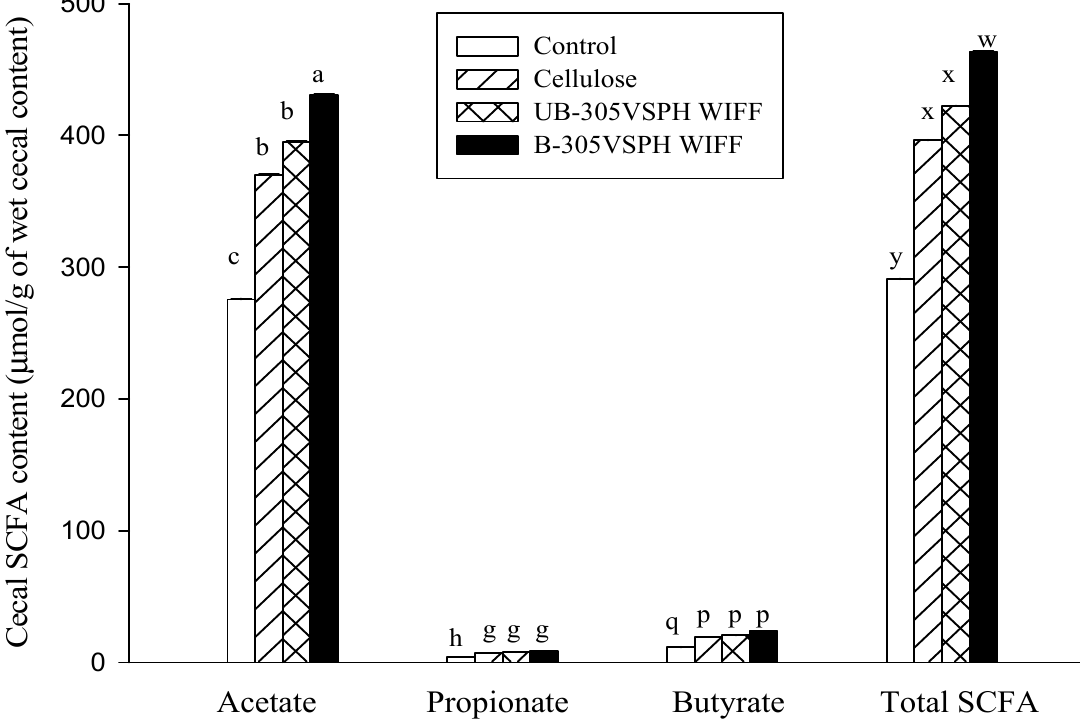
Figure 1. The short-chain fatty acid (SCFA) concentrations in the cecal contents of hamsters fed diets with cellulose or WIFF of IB-305VSPH and B-305VSPH. a-c, h-g, p-q, w-y Values (means ± SD, n = 8) for acetate, propionate, butyrate, and total SCFA, respectively, are significantly different ( p < 0.05).